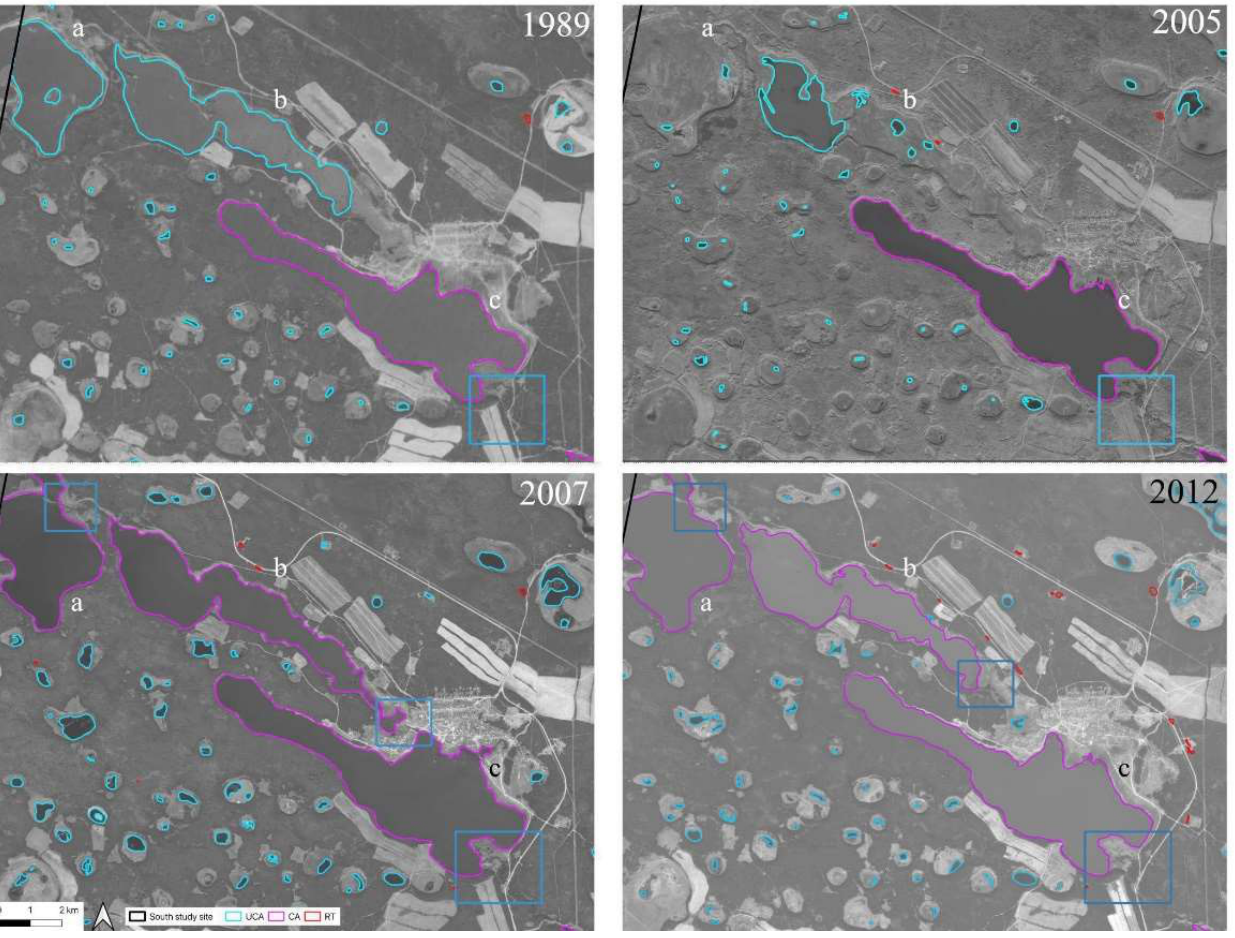
Figure 13. Comparison between 12 July 198925 September 2005, 2 August 2007, and 25 July 2012 images (south study site (the center of the image is 62.270N 130.651E). Two large unconnected alas lakes are outlined in blue (lakes a, b) and one connected alas lake is outlined in purple (lake c) (1989 scene). Lakes a and b changed designation to CA lakes in the 2007 scene. The inflows to the lakes are indicated by the blue squares.